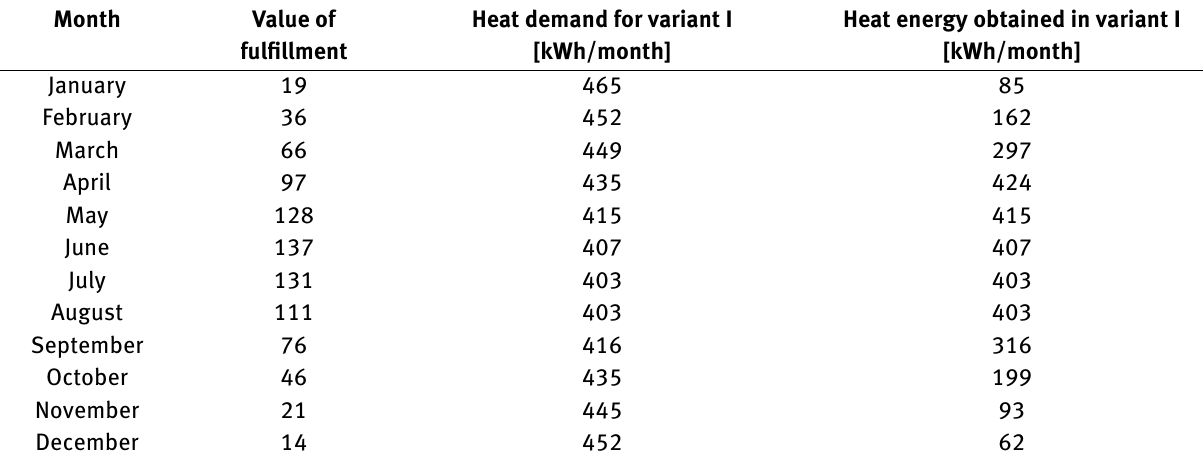
Table 6: Value of thermal energy obtained by the solar installation (Variant I).